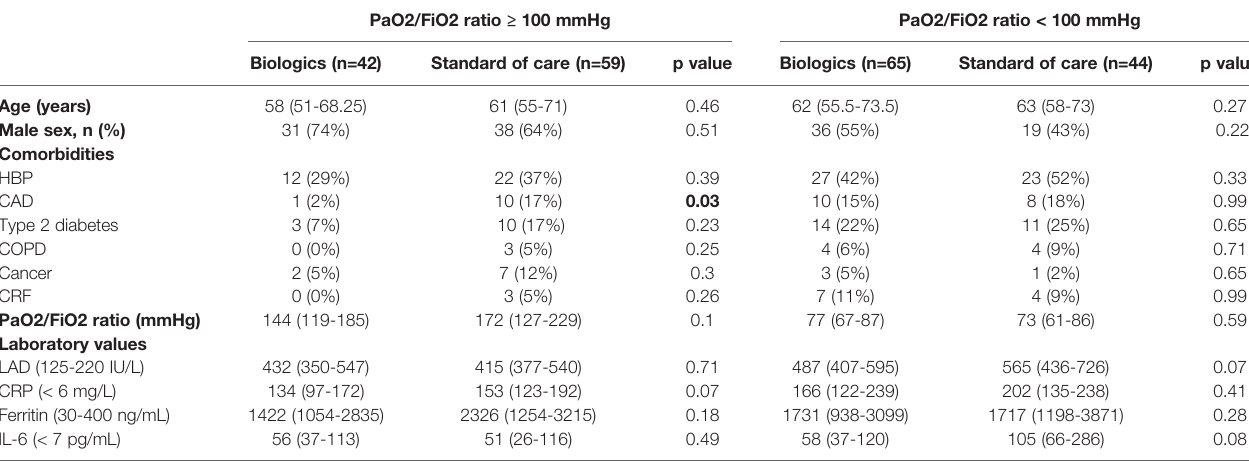
TABLE 7 | Clinical and serological features of patients with a PaO2/FiO2 ratio < 100 mmHg and ≥ 100 mmHg.